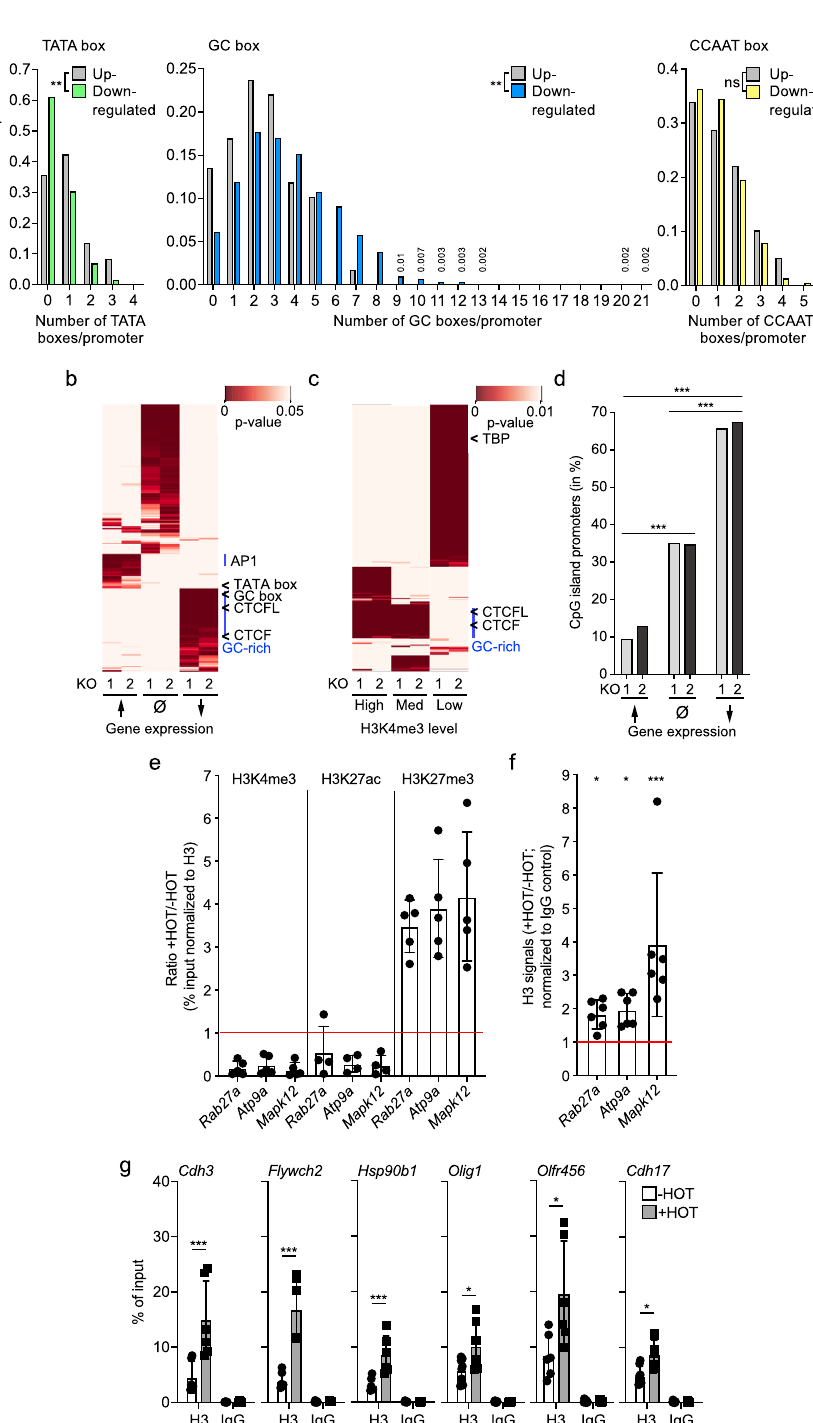
Figure 2. CpG island promoters are preferentially affected upon Ash2l loss. ( a ) The presence of TATA, GC and CCAAT boxes in promoter region of genes (-1000 to + 100 bp) that were up- or downregulated. Kolmogorov–Smirnov test: ** < 0.01; ns, not significant. ( b ) Putative transcription factor binding sites in promoters of up- or downregulated genes and of genes that did not show significant changes in expression (Ø). Indicated are the TATA box and the GC box and areas in which binding sites for AP1 proteins (AP1) and factors that interact with GC-rich sequences (GC) are preferentially found. Moreover, CTCF and CTCFL binding sites are indicated. ( c ) Putative transcription factor binding sites of promoters with high, medium, or low H3K4me3. Indicated sites are as described in panel ( b ). ( d ) Indicated are the percentage of CpG island promoters of genes that are up- or downregulated or unaffected in KO1 and KO2 cells in response to Ash2l loss (upregulated: 176 genes in KO1 and 206 genes in KO2; downregulated: 1118 genes in KO1 and 1600 genes in KO2; not changed: 35,911 genes in KO1 and 35,399 in KO2). Chi-square with Yates correction, two tailed: *** < 0.001. ( e , f ) Three genes with promoters characterized by strong CGIs were analyzed for the presence of the indicated histone marks (panel e ) and H3 occupancy (panel f ) using ChIP-qPCR of KO2 cells treated ± HOT for 5 days. Mean values ± SD (n = 4–6) are given (* < 0.05, *** < 0.001). ( g ) Histone H3 ChIP-qPCR of promoter regions of the indicated genes in iMEF KO2 cells treated ± HOT for 5 days. Rabbit IgG served as control. Mean values ± SD (n = 6) are given (* < 0.05, ** < 0.01, *** <